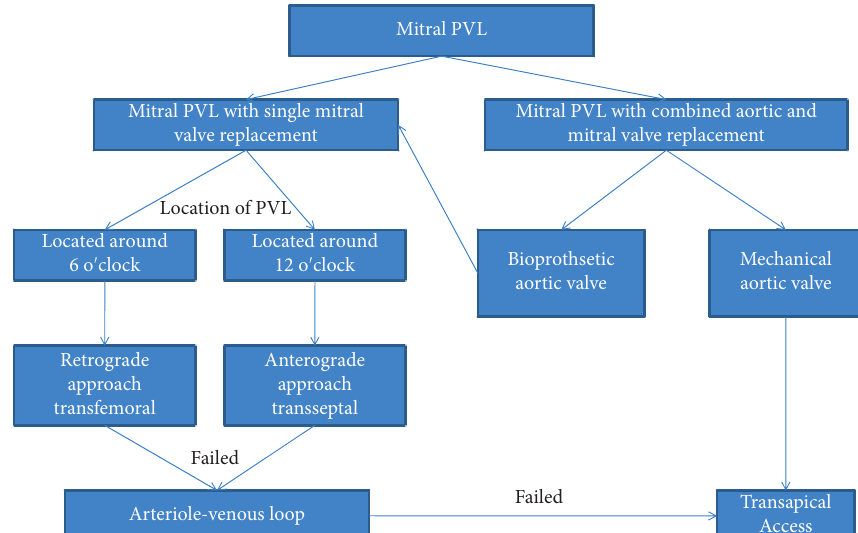
Figure 1: Protocol strategy for the different